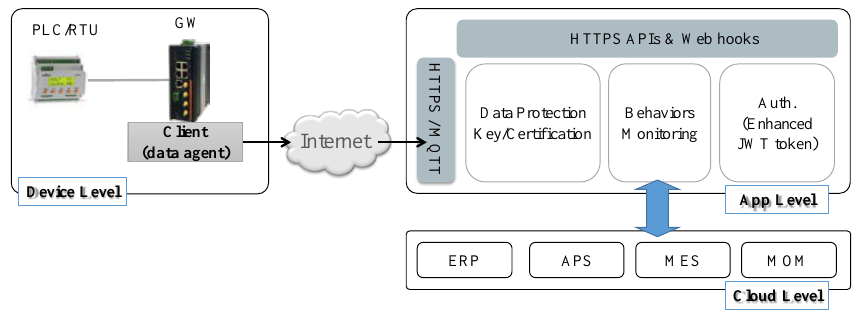
Figure 2. The SCADA system.